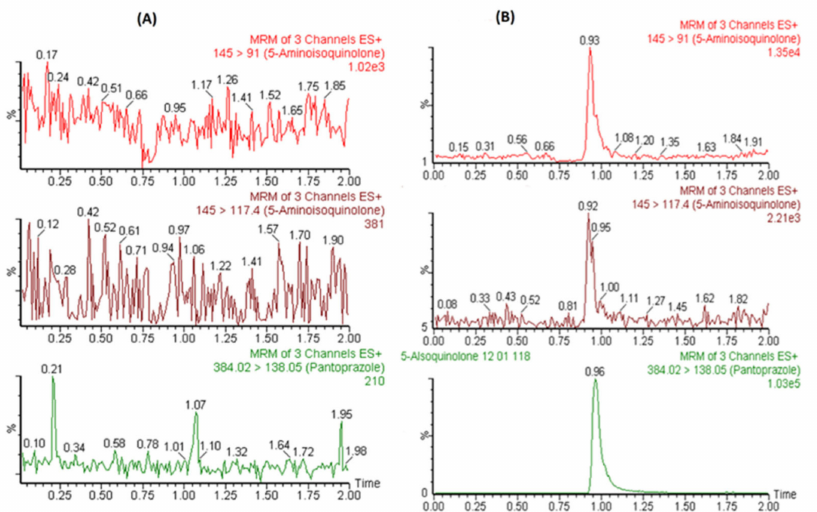
Figure 2. Representative MRM chromatograms of 5-AIQ and IS for blank plasma ( A ) and plasma spiked at LLOQ (1.0 ng/mL) concentration ( B